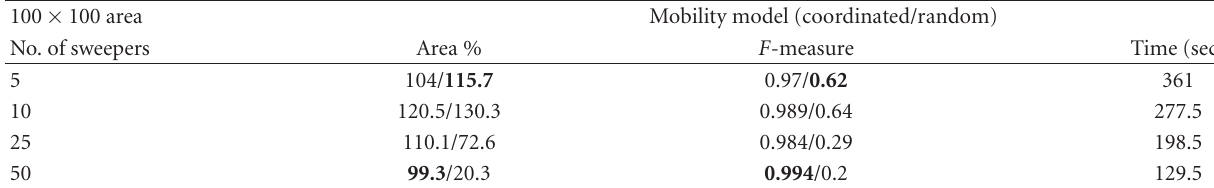
Table 2: Mobility models.